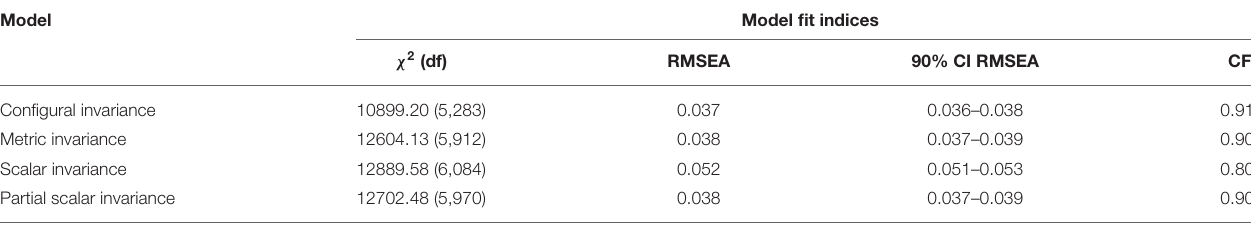
TABLE 3 | Measurement invariance models and goodness-of-fit indexes of multigroup analyses of developmental assets across countries. Model